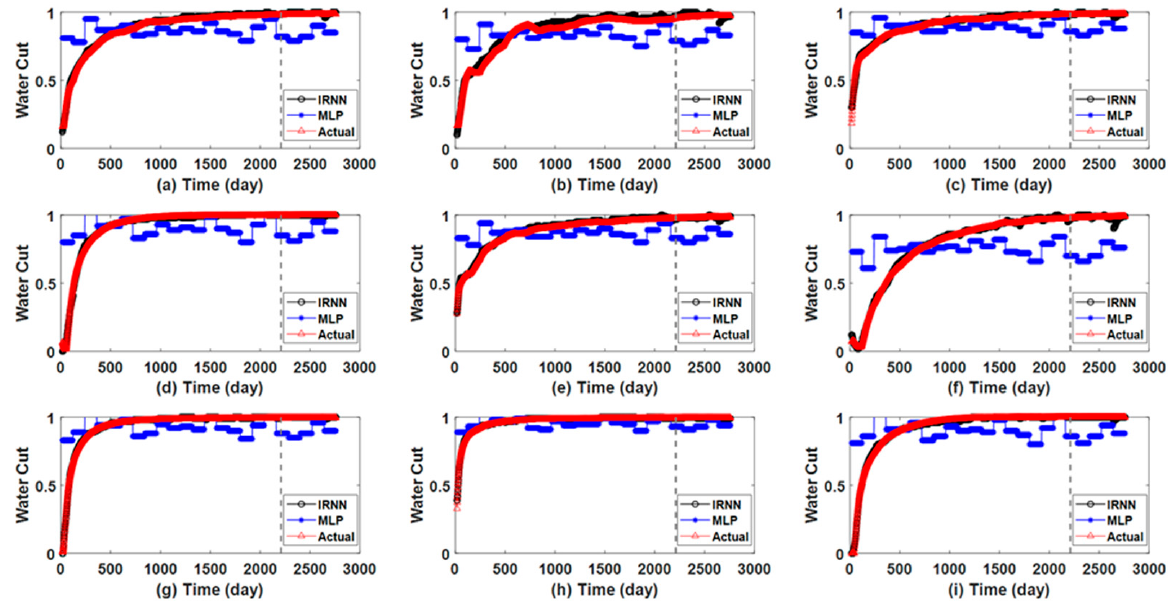
Figure 4. The water cut curves of the three-channel model. The red lines with triangles represent the actual results obtained by the simulator, the black lines with circles represent the results obtained via IRNN, and the blue lines with dots are the results obtained via MLP. The history matching and predicting periods are divided by the grey vertical dashed line. From PRO-01 to PRO-09, the water cut curves of 9 producers are demonstrated in ( a – i ) successively.